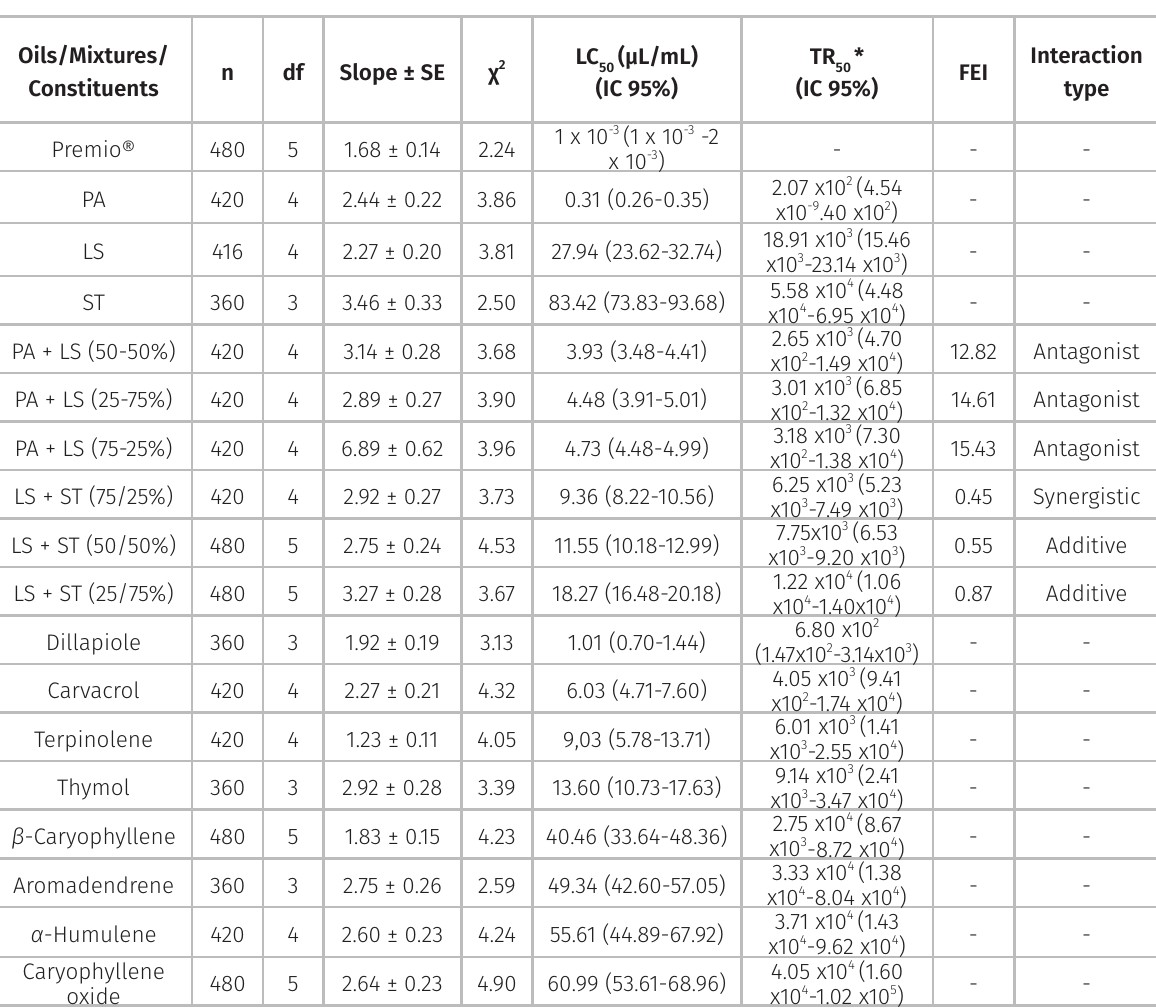
Table II. Residual activity of essential oils from the leaves of Piper aduncum L. (PA) (Piperaceae), Schinus terebinthifolius Raddi (Anacardiaceae) (ST) and Lippia sidoides Cham. (Verbenaceae) (LS), their binary mixtures, and Premio ® as a positive control and selected oils constituents against lavae of 3 rd instar on Plutella xylostella (L.) (Lepidoptera: Plutellidae) in laboratory. Temp.: 25 ± 1°C, RH: 65 ± 5% and photophase: